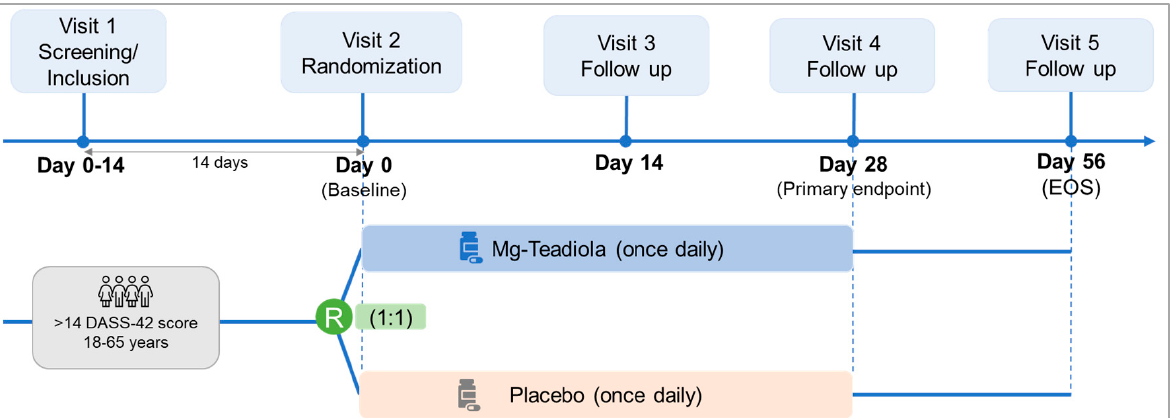
Figure 1. Study design. DASS, Depression Anxiety Stress Scale; EOS, end of study; Mg-Teadiola, combination of 150 mg magnesium, 0.7 mg vitamin B6, 0.1 mg vitamin B9, and 1.25 µg vitamin B12, + 222 mg of rhodiola extract and 125 mg of green tea extract including 50 mg of L-theanine; R, randomization.